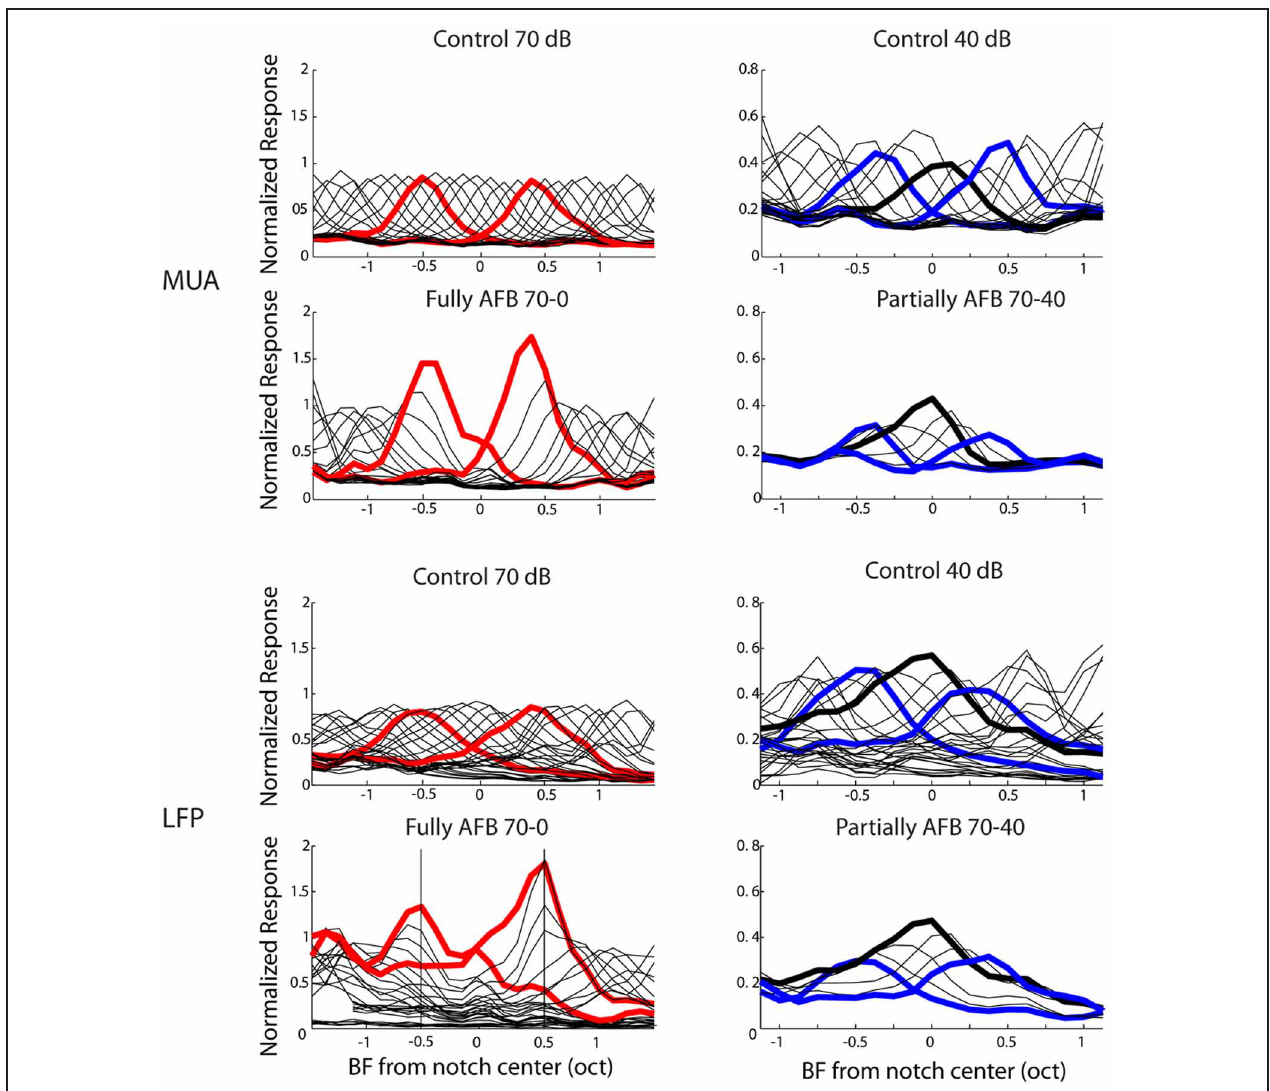
FIGURE 7 | Averaged “patterns of excitation” for MUA (first and second rows) and LFPs (third and fourth rows) in the 1-octave AFB condition. Neural activity was normalized to the maximal activity obtained in the ctrl-70 condition and was smoothed with a moving average. In the first (for MUA) and third (for LFPs) rows, excitation patterns for the ctrl-70 (first column) and the ctrl-40 (second column) are represented. In the first column, the second (for MUA) and fourth (for LFPs) rows represent the excitation patterns for the fully AFB condition. The “excitation patterns” for frequencies at the upper